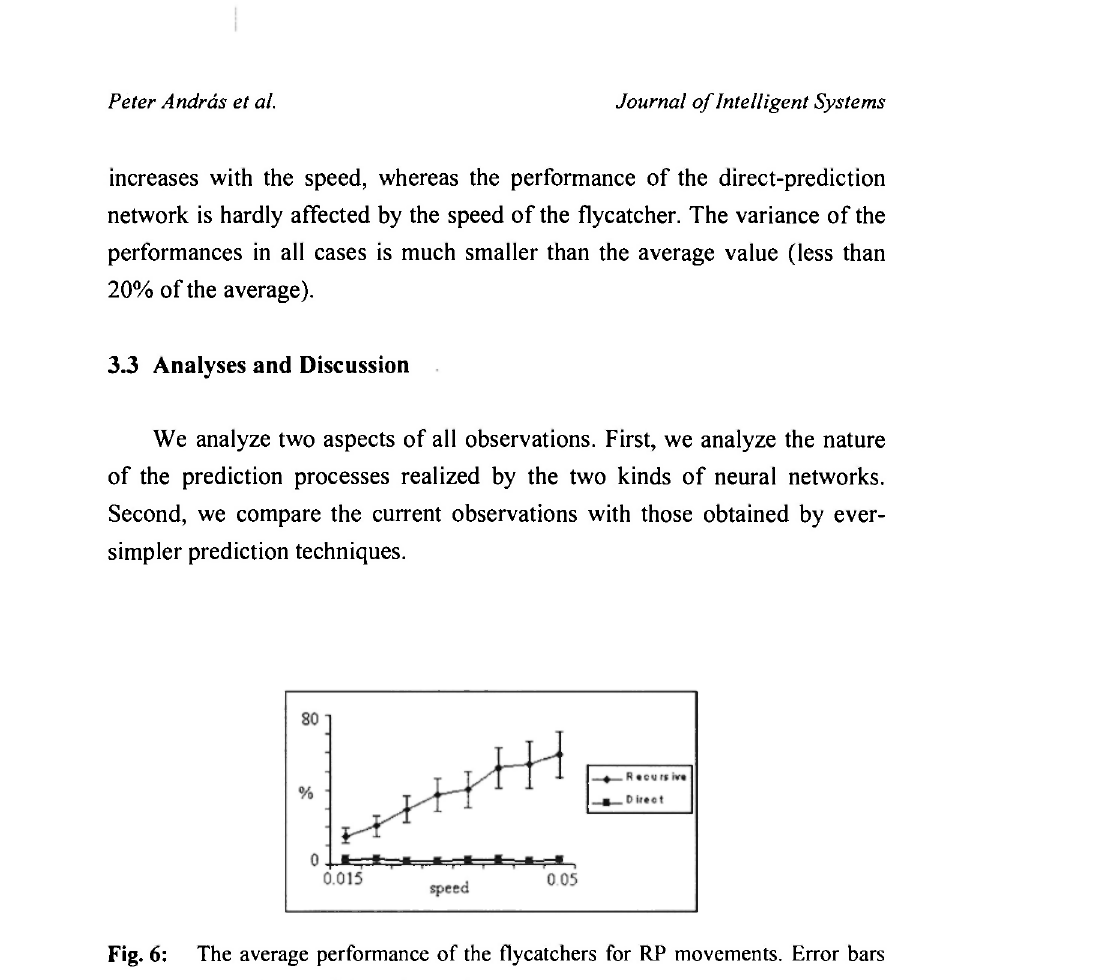
Fig. 6: The average performance of the flycatchers for RP movements. Error bars show 99% confidence intervals.